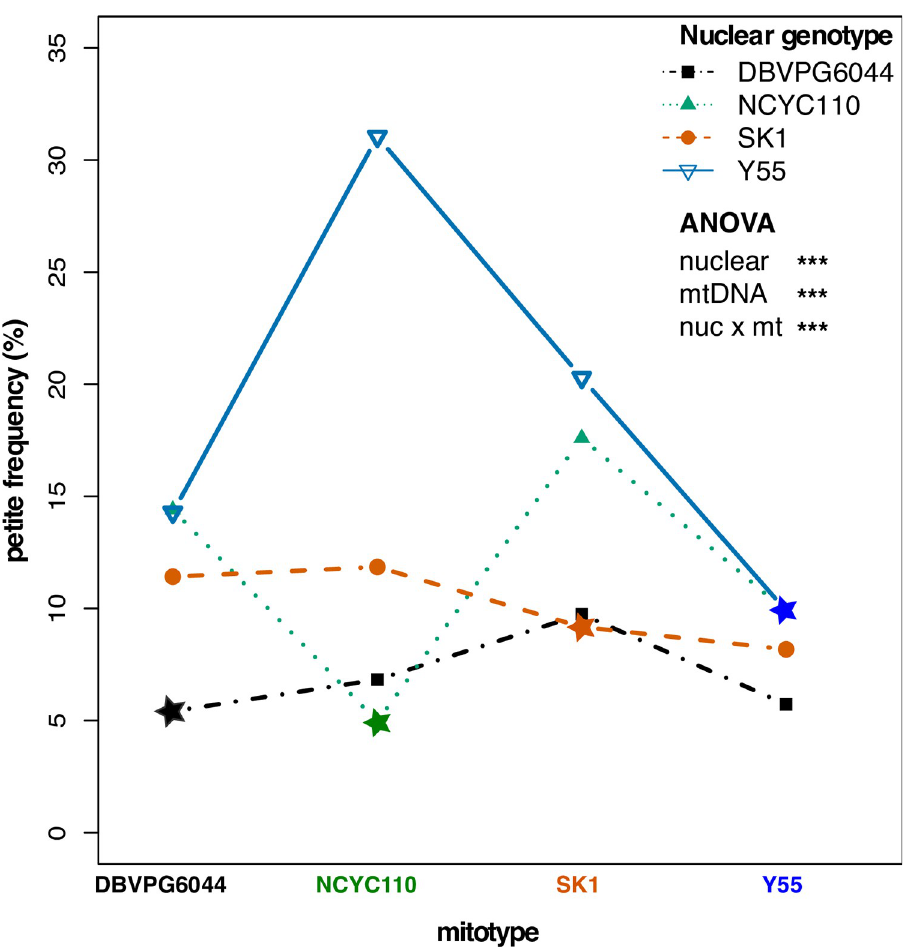
Fig 3. Coadapted mitonuclear interactions stabilize mtDNAs. Petite frequencies for strains containing 4 nuclear and 4 mtDNA backgrounds are shown as an interaction plot. Colored lines connect a nuclear genotype paired with different mitotypes. The original mitonuclear genotype combination is starred. The nonparallel lines indicate mitonuclear epistasis. ANOVA revealed highly significant nuclear, mtDNA, and mitonuclear genotypes contributions (S5 Table) . *** P �